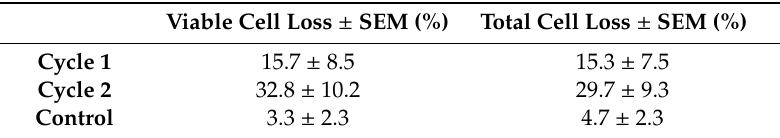
Table 2. E ff ect of hydrodynamic forces on cell viability as shown by viable cell loss and total cell loss after first and second cycle of the spiral microfluidic chip. Data represent the average of 3 experiments ± Standard error of the mean (SEM).